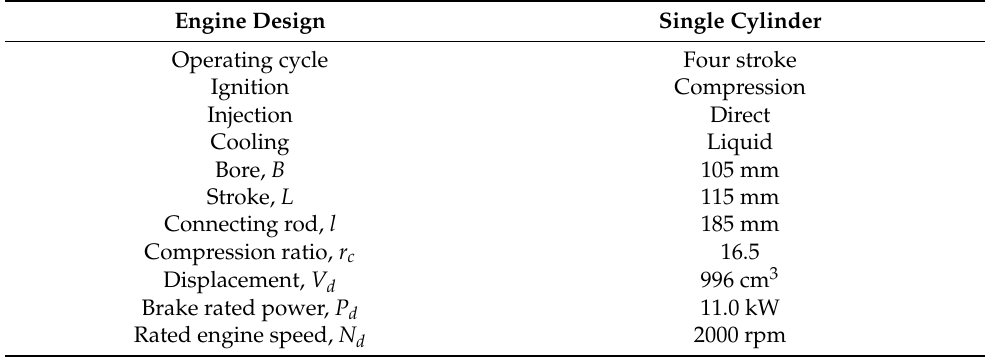
Table 1. Main engine